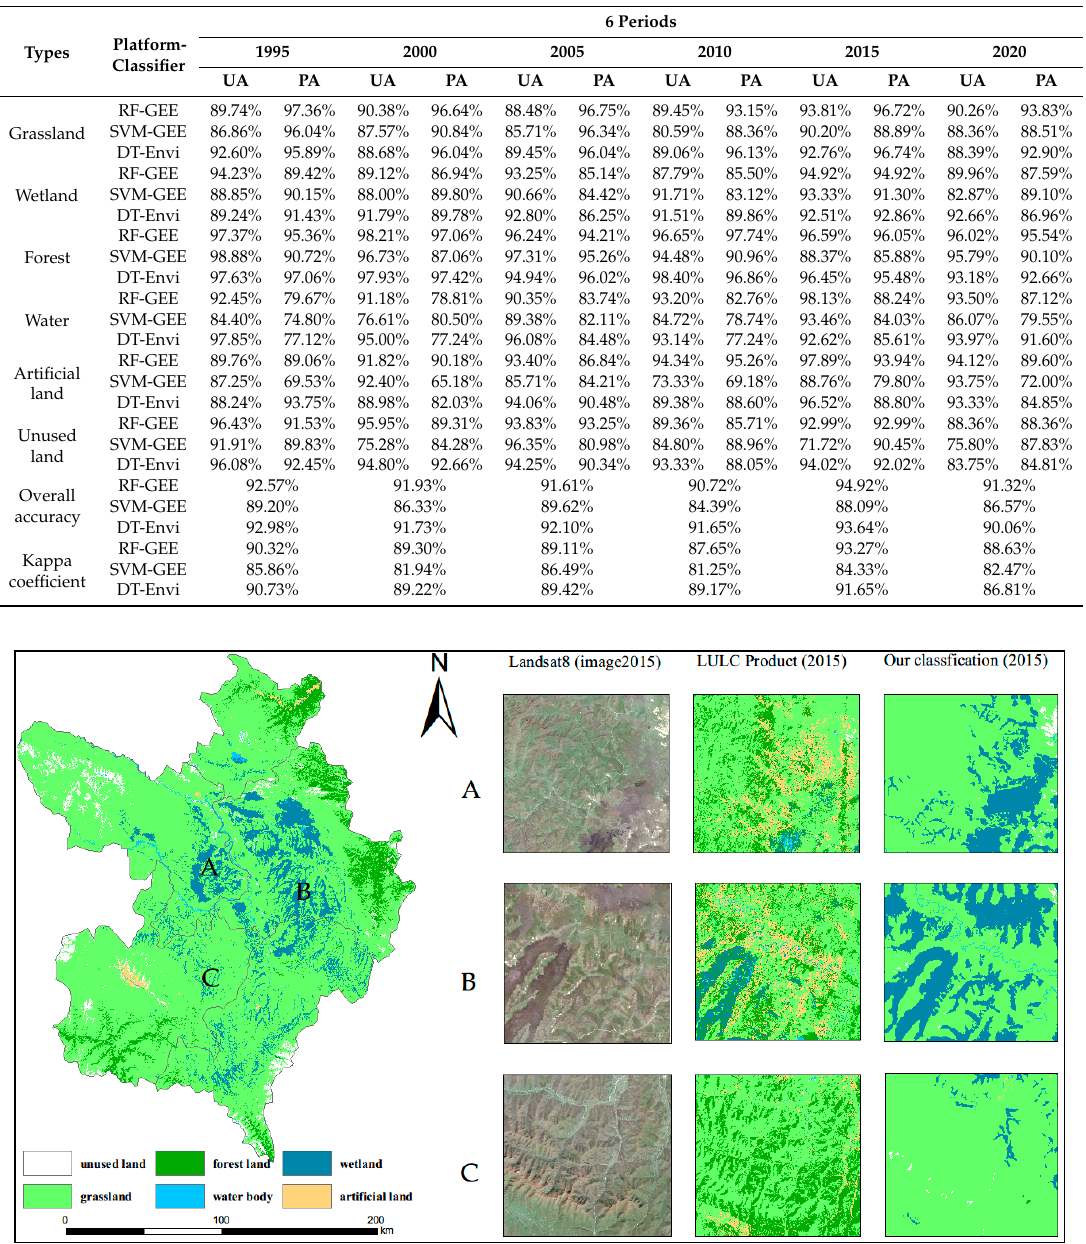
Table 2. Accuracy results for land cover types for 6 years with 3 algorithms.